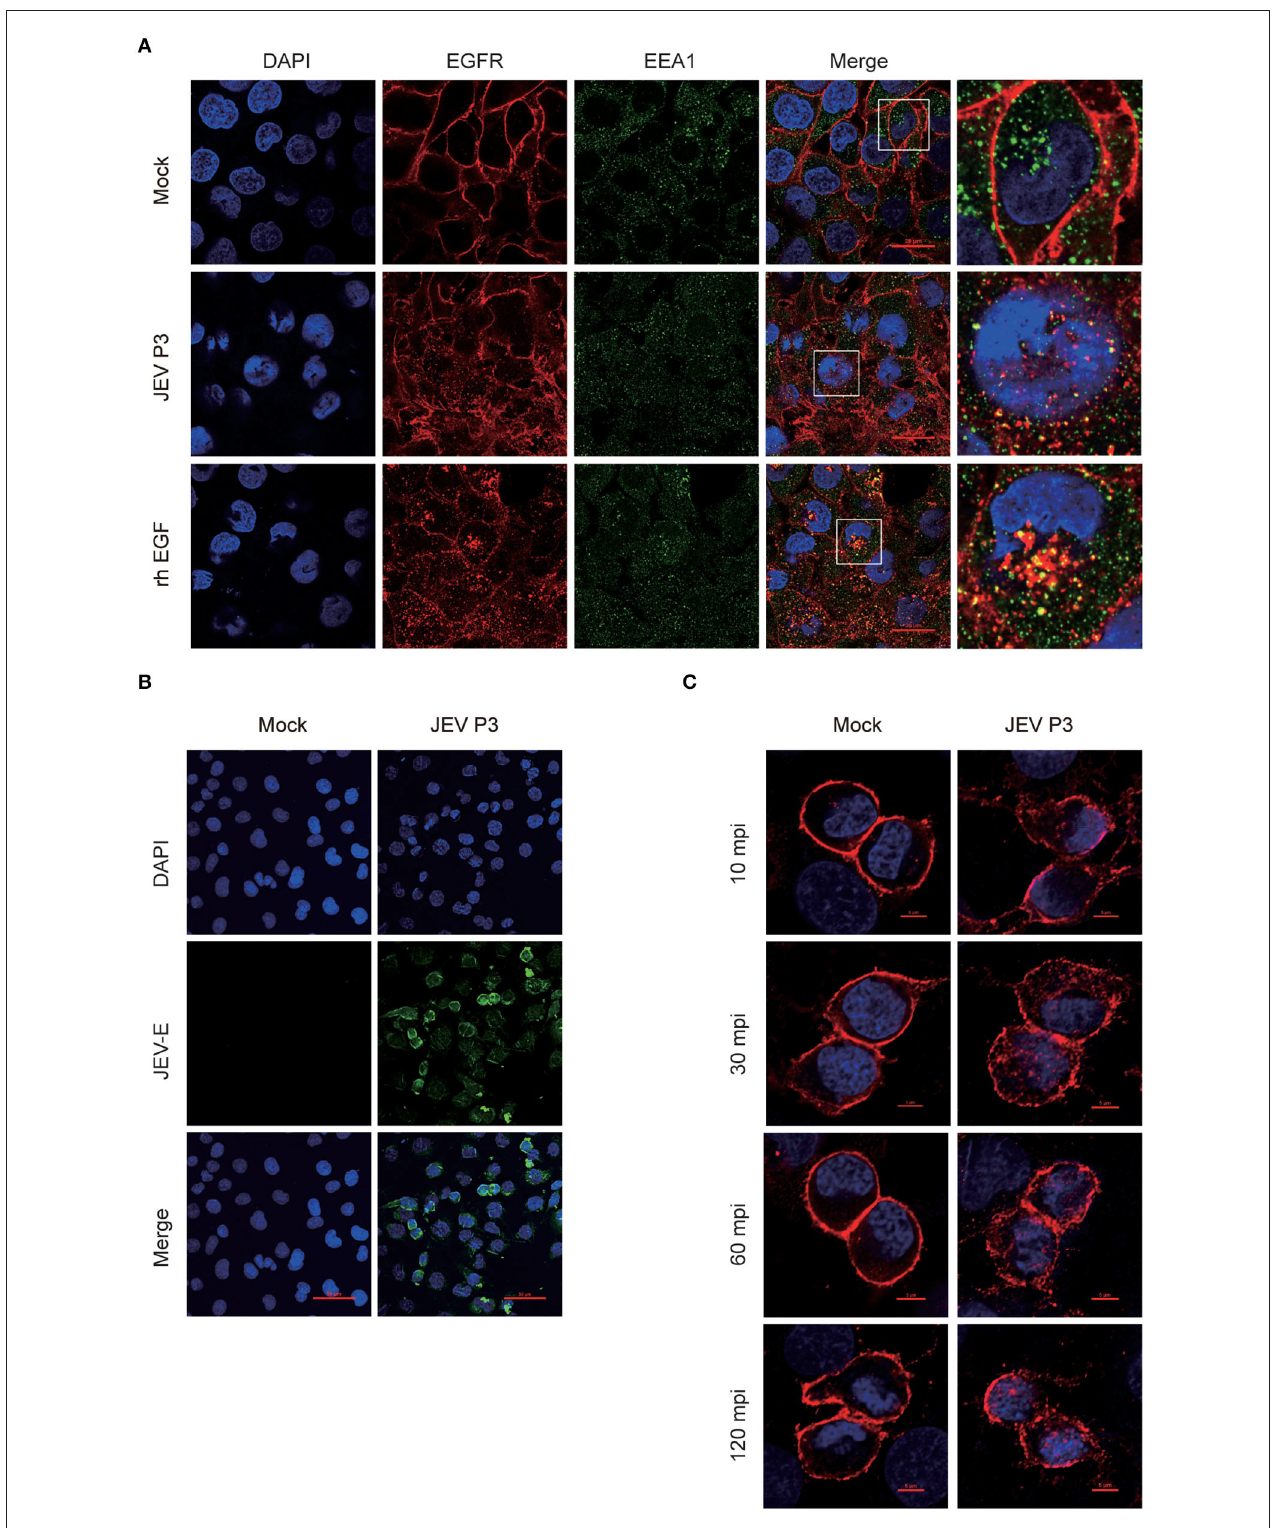
FIGURE 2 | Internalization of EGFR in JEV-infected hBMECs. hBMECs were infected with JEV P3 (MOI = 1) for 16h, and then images were captured by confocal laser scanning microscopy. (A) Uninfected cells and rhEGF-stimulated cells (10ng/ml rhEGF for 30min) were utilized as negative and positive controls,